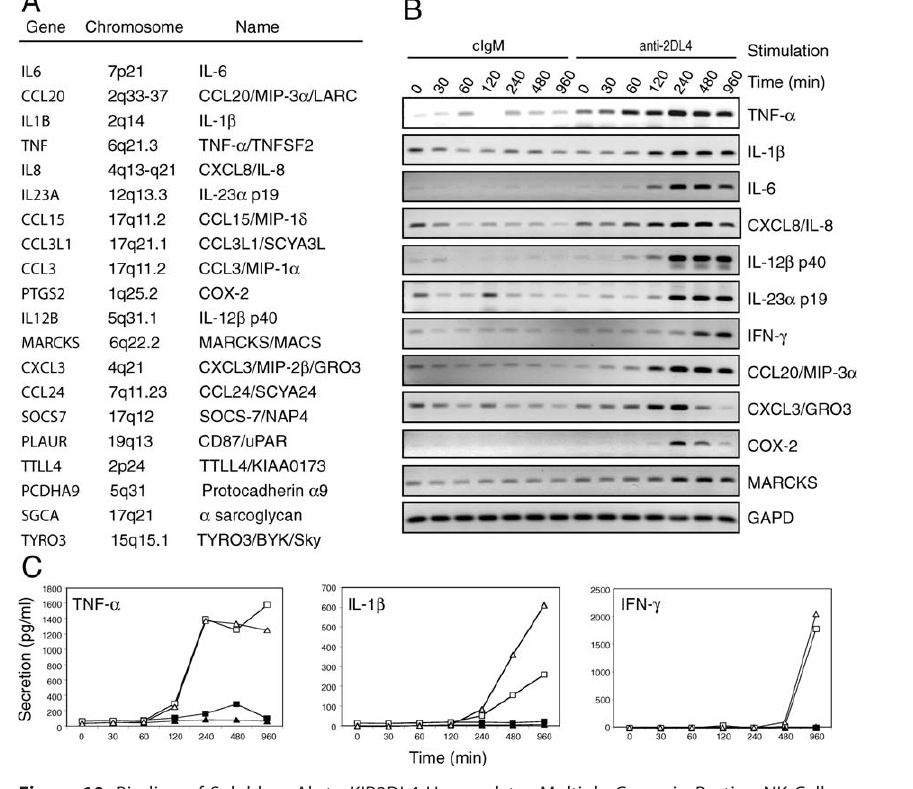
Figure 10. Binding of Soluble mAb to KIR2DL4 Up-regulates Multiple Genes in Resting NK Cells (A) All genes exhibiting greater than 2-fold up-regulation in microarray experiments with resting NK cells of at least two of three different individuals are listed. (B) Semiquantitative RT-PCR was performed on total RNA isolated at different time points from resting NK cells stimulated with either control IgM mAbs or anti-KIR2DL4 IgM mAbs 36 and 64. (C) Time course of TNF- a , IL-1 b , and IFN- c secretion by resting NK cells stimulated with anti-KIR2DL4 mAbs 36 and 64 (open symbols) or control IgM mAbs (closed symbols). Squares and triangles represent data obtained from two different donors. Protein secretion was detected by